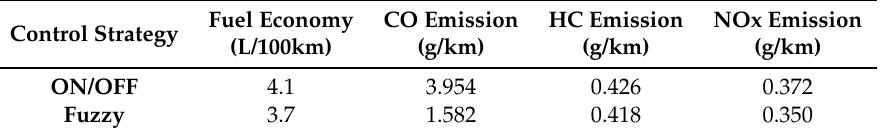
Table 7. Emissions and fuel consumption results